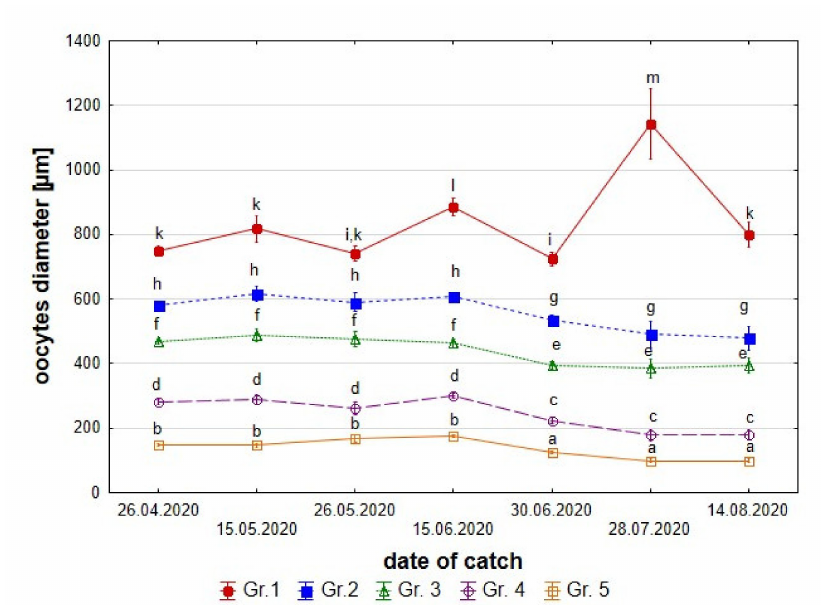
Figure 6. Average sizes of the five groups of stone moroko Pseudorasbora parva oocytes from April– August (see the text for the group description). Values with different letters show significant differ- ences ( p < 0.05; ANOVA test).